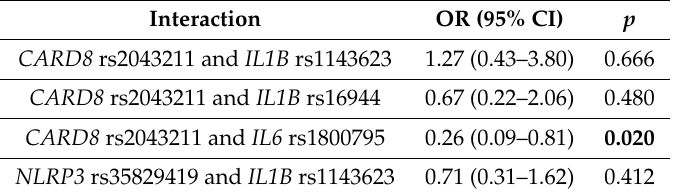
Table 3. The e ff ect of interactions between CARD8, NLRP3, IL1B , and IL6 polymorphisms on PCOS